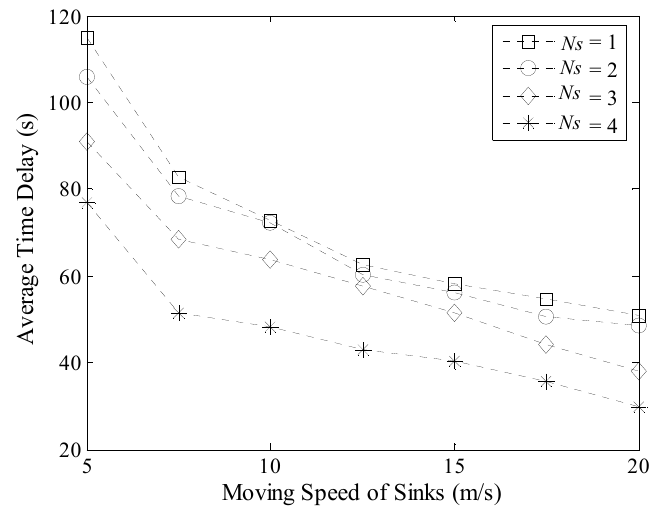
Figure 25. Average time delay with different moving speeds of Sinks.